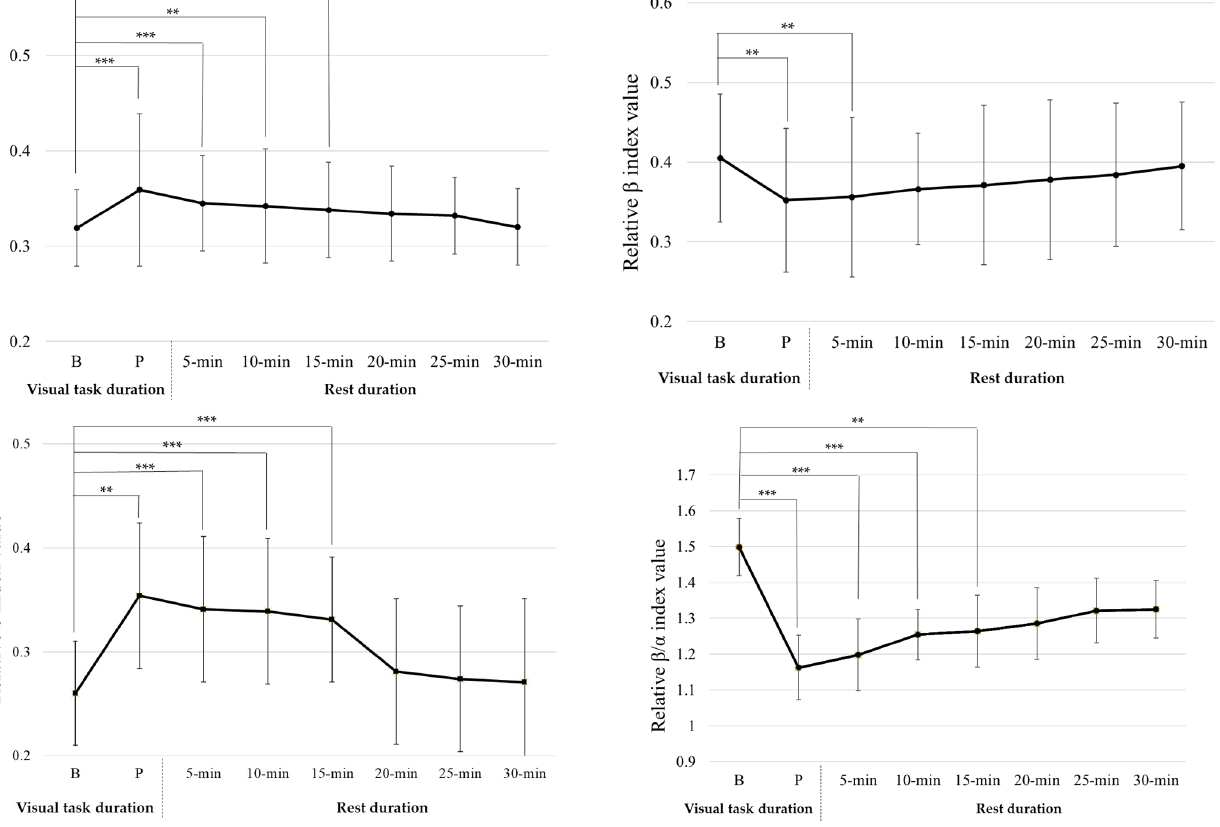
Figure 3. Wilcoxon signed-rank test results for 4 EEG relative power indices for 15 min visual task baseline, post-experiment, and rest time. Note: B: Baseline, p : Post-experiment, ** p <0.01; *** p < 0.001.